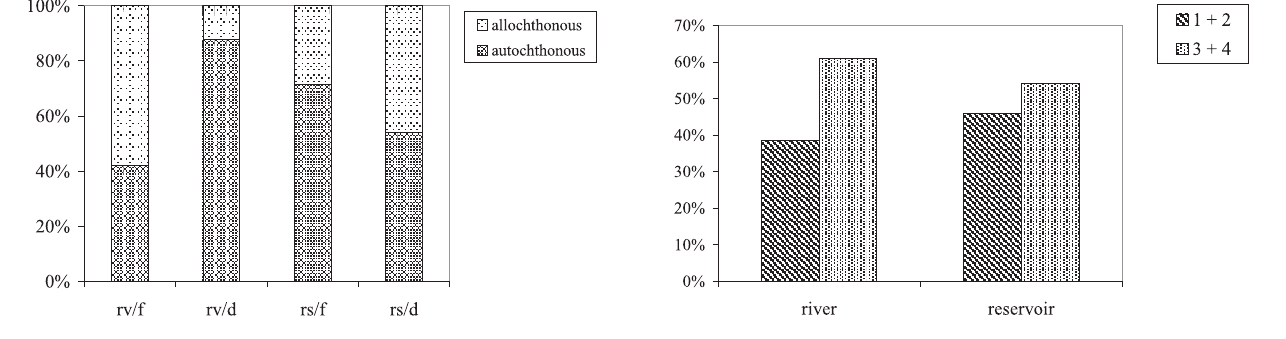
Fig. 4. Percentage of stomachs of L. taeniofasciatus with different degrees of fullness. 1 + 2 = half full, and 3 + 4 = totally full.